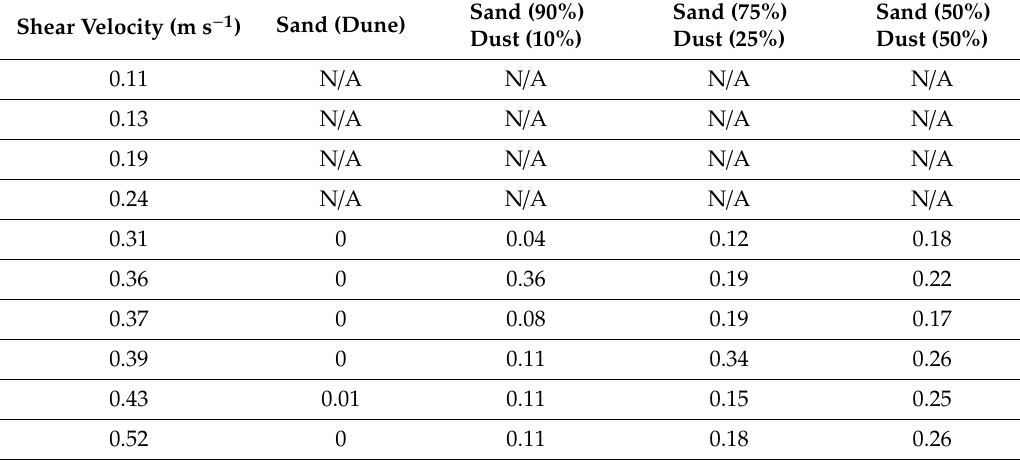
Figure 4. Saltation mass from the wind tunnel measurements of the reference samples under various shear velocities. Note that no distinct saltation mass was recorded in shear velocity below 0.31 m s − 1 . Table 1. The dust fraction received in the saltation mass calculated as the class weight of the dust particles ( < 63 µ m) in the total weight of the saltation: [1 − (dust (g) / sand (g) + dust (g)]. Note that no saltation was recorded in shear velocity below 0.31 m s − 1 .